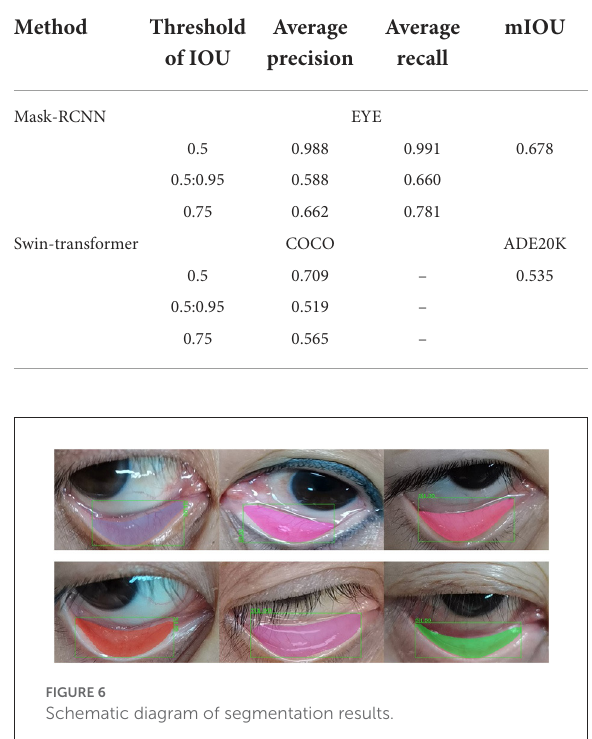
TABLE 1 The average precision and recall under different thresholds of mIoU.